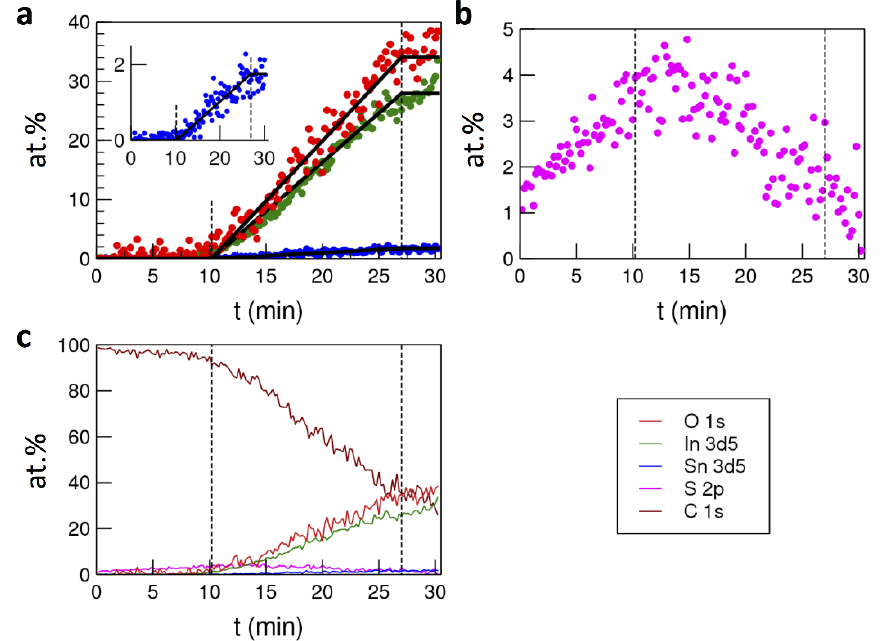
Figure 5. XPS depth profile characterization of ( a ) the ITO layer, ( b ) the relative S abundance, and ( c ) the overall elemental depth profile distribution from the printed layers onto ITO. The elemental depth profiles (reported as dots or lines) are obtained by analyzing the following species: O 1s (red), In 3d 5 (green), Sn 3d 5 (blue), S 2p (magenta), C 1s (brown).